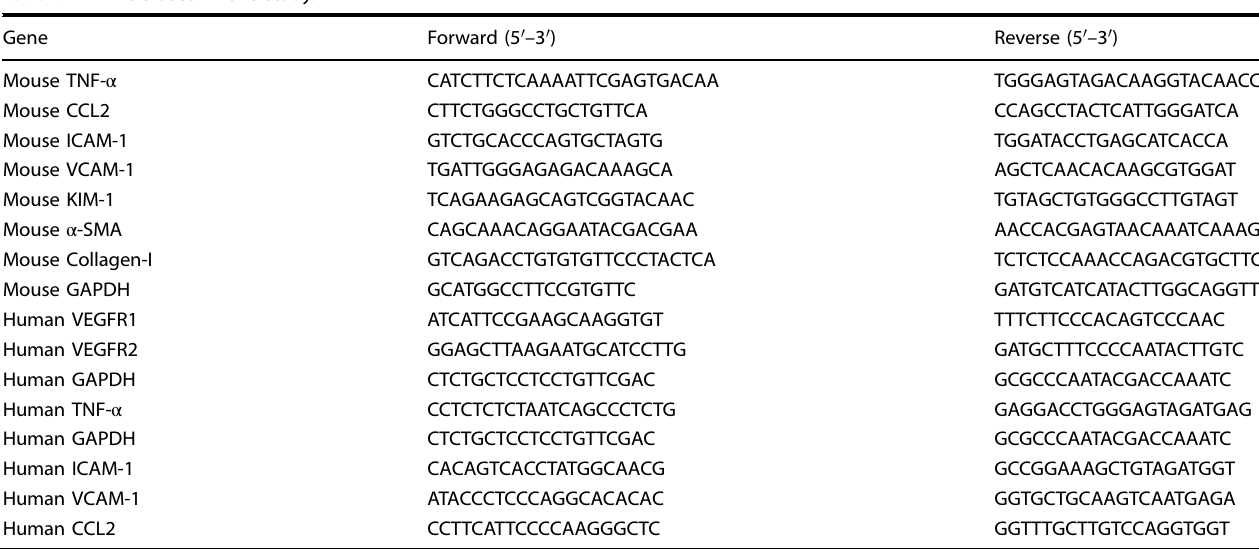
Fig. 8 Working models propose tubular sEV-VEGF-A mediated tubule-PTCs communication, which functions as an intrinsic repair mechanism in ischemic AKI. We demonstrated that hypoxia triggers a shift of tubular VEGF-A secretion from the free form to sEV, favoring the endothelial proliferation of PTCs after ischemic AKI. Furthermore, supplementary treatment with VEGF-A + sEV ef fi - ciently ameliorated PTC rarefaction and protected against the chronic progression of AKI. Schematic created with BioRender.com. Table 1. Primers used in this